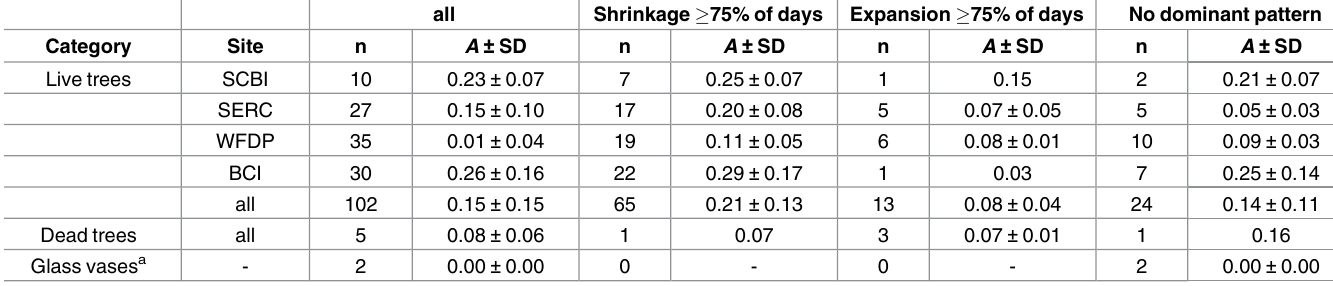
Glass vases a Bands are classified based on wavelet analysis of the relationship of Δ c r to T band . a See S4 Appendix